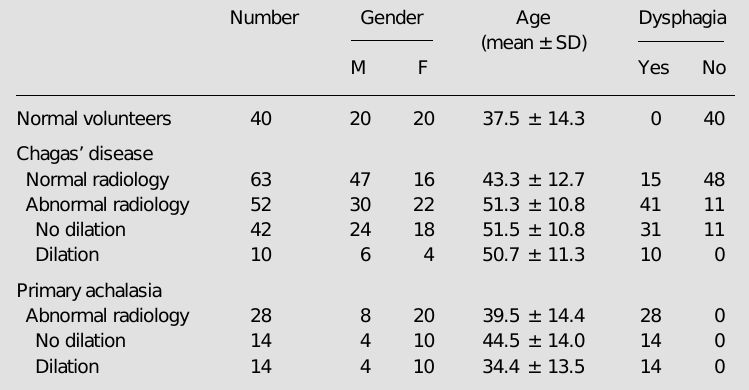
Table 1 - Characteristics of the population